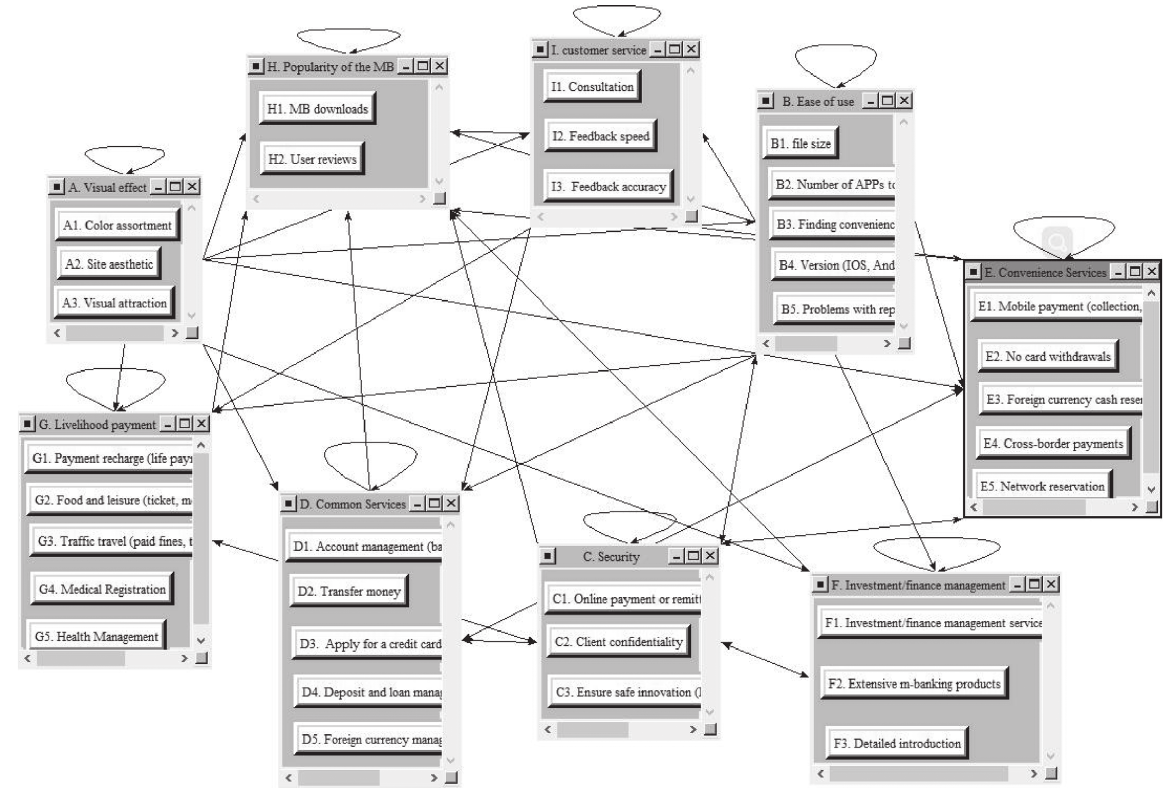
Figure 3: Network structure of the evaluation model.